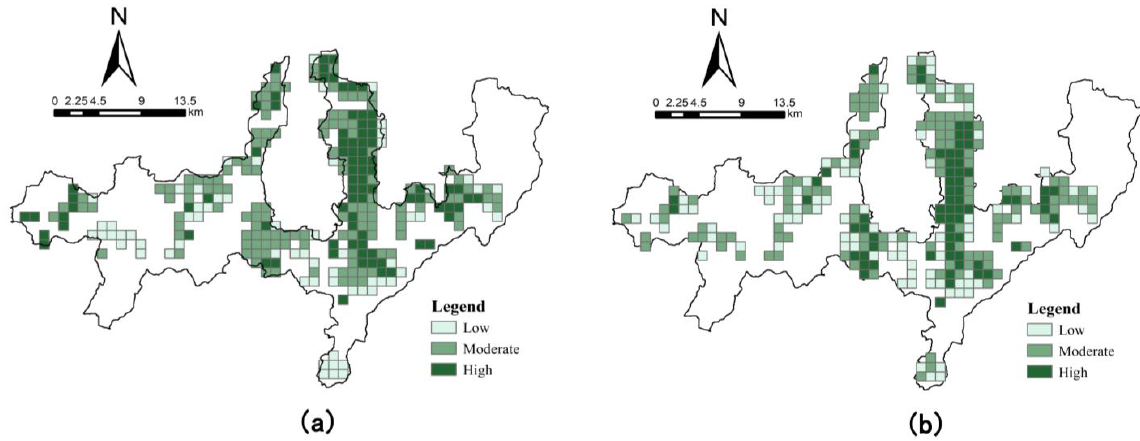
Figure 7. ( a ) Spatial map of woodland-landscape-fragmentation index and ( b ) distribution of overall biological reserve landscape-fragmentation index. biological reserve landscape-fragmentation index.